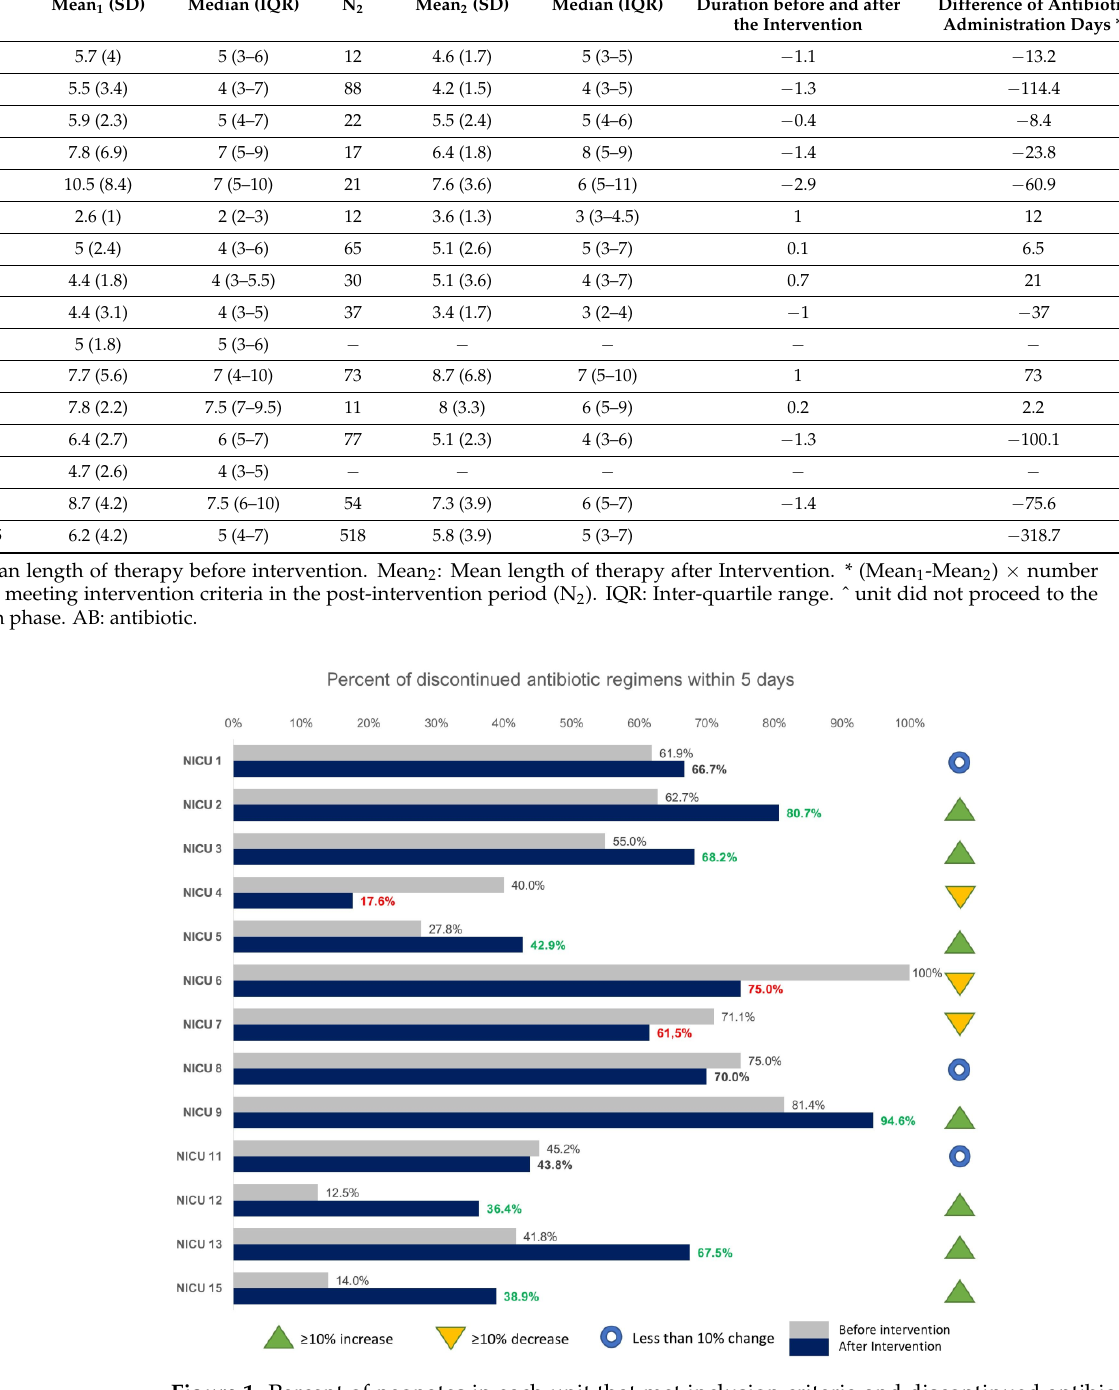
Figure 1. Percent of neonates in each unit that met inclusion criteria and discontinued antibiotics within 5 days of initiation of empiric treatment.